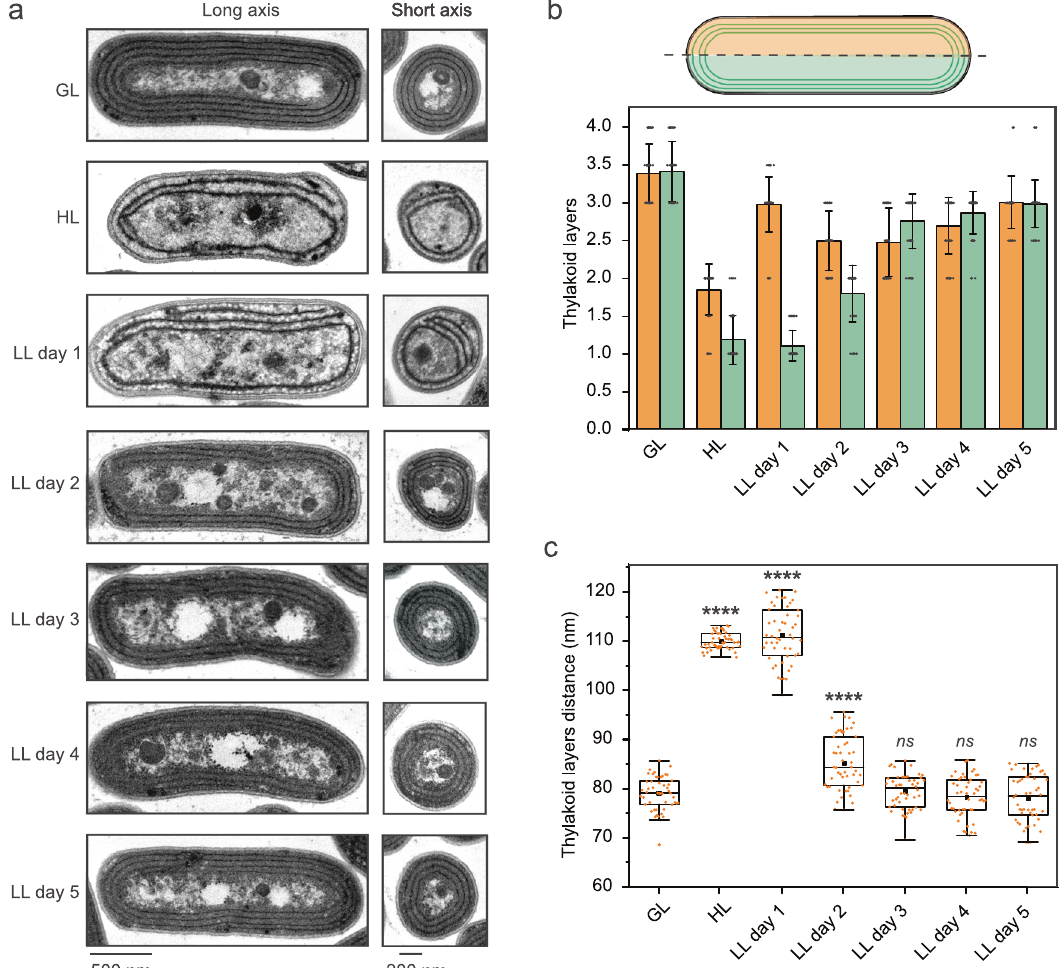
Fig. 1 The ultrastructures of thylakoid membranes during its light-regulated biogenesis in Synechococcus . Cells were grown under growth light (GL), high light (HL), and HL-grown cells were transferred to low light (LL) conditions for 5 days. a Representative transmission electron microscope (TEM) images of cells grown under GL, HL, and HL-grown cells transferred to LL for 5 days. In the thylakoid elongation models, existing membrane parts are in green and new ones in orange during the initial steps of the biogenesis process. Representative TEM images were derived from at least three biologically independent preparations with similar results. b Number of thylakoid membrane layers on both longitudinal sides of cells. Values are means ± SD; n = 50 cells in total from three biologically independent experiments c Distance between thylakoid membrane layers. n = 50 cells from three biologically independent experiments for each condition. Asterisks indicate the statistically signi fi cant differences compared to GL cells. Box plots display the median (line), the average ( fi lled square), the interquartile range (box), and the whiskers (extending 1.5 times the interquartile range). For HL p = 2.92 × 10 − 77 , for LL day 1 p = 5.89 × 10 − 57 , and for LL day 2 p = 9.42 × 10 − 10 . ns, not signi fi cant. Statistical analysis was performed using a two-sided two-sample t